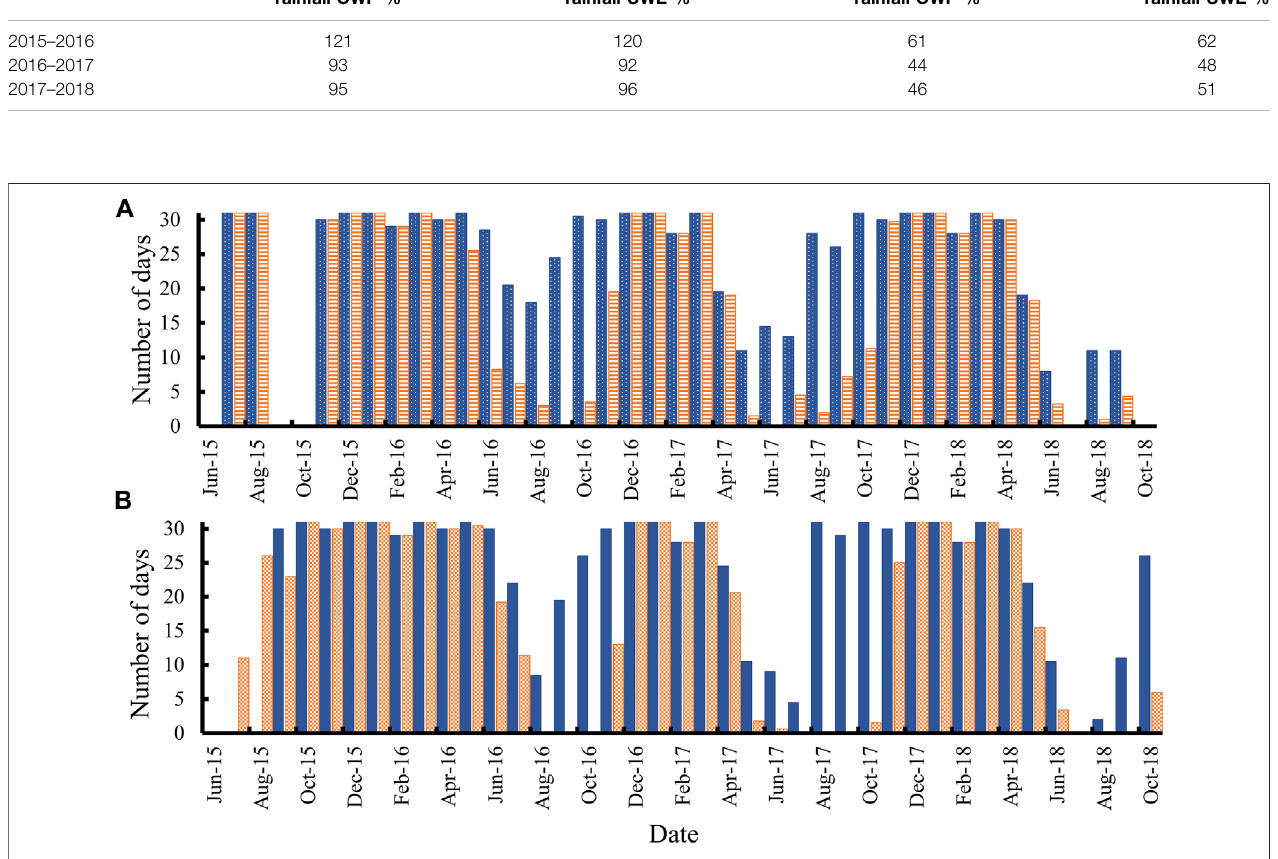
FIGURE 4 | Number of days each month when soil moisture tension at 10 cm depth was between 0 and − 59 KPa in Control or reduced rainfall (RR) plots at (A) UWE and (B) OWP.